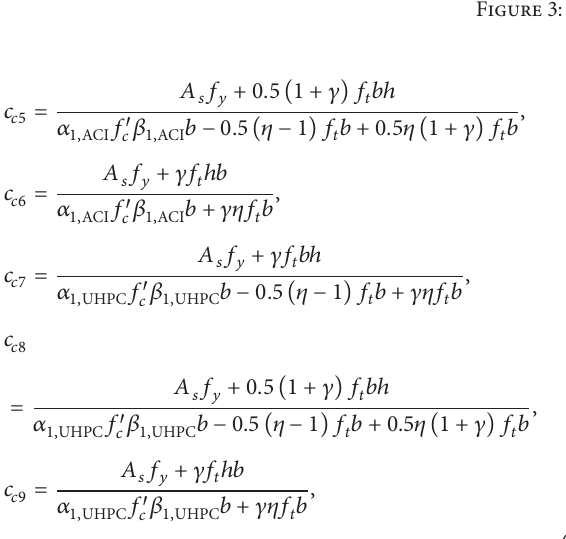
Figure 3: Stress block